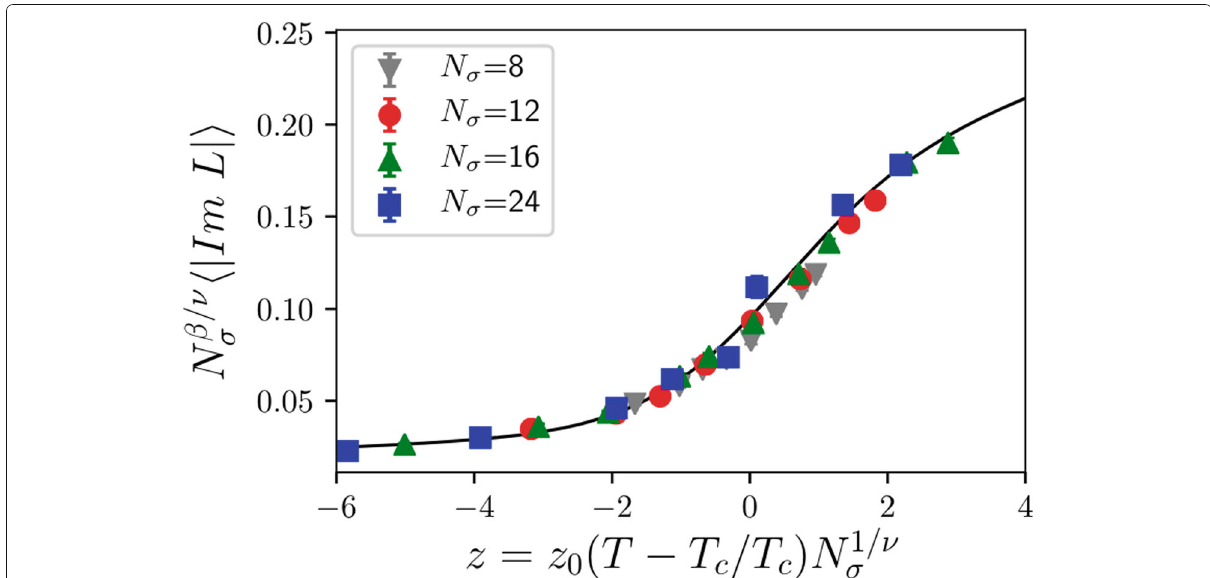
Fig. 4 The Z ( 2 ) scaling of the expectation value of the imaginary part of Polyakov loop near the chiral crossover transition temperature T c for different lattice volumes, taken from